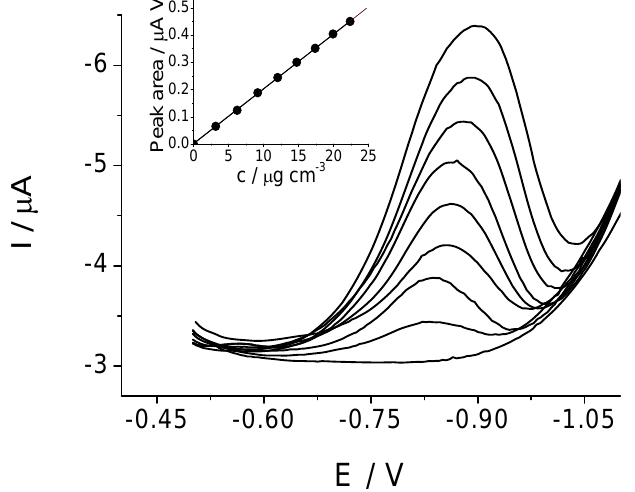
Figure 4. Differential pulse voltammograms recorded at the BiF-GCE for different concentrations of clothianidin in Britton–Robinson buffer solution pH 8.0. The inset shows the corresponding calibration